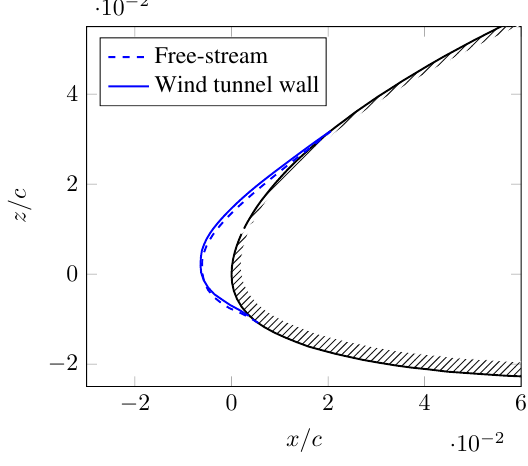
Figure 11. Inviscid wall effect on ice accretion for a AH- 94-W-145 airfoil, c = 0 . 75m, U ∞ = 40ms − 1 , T ∞ = − 10 ◦ C, LWC = 0.3gm − 3 , MVD = 15µm and IWC = 0.